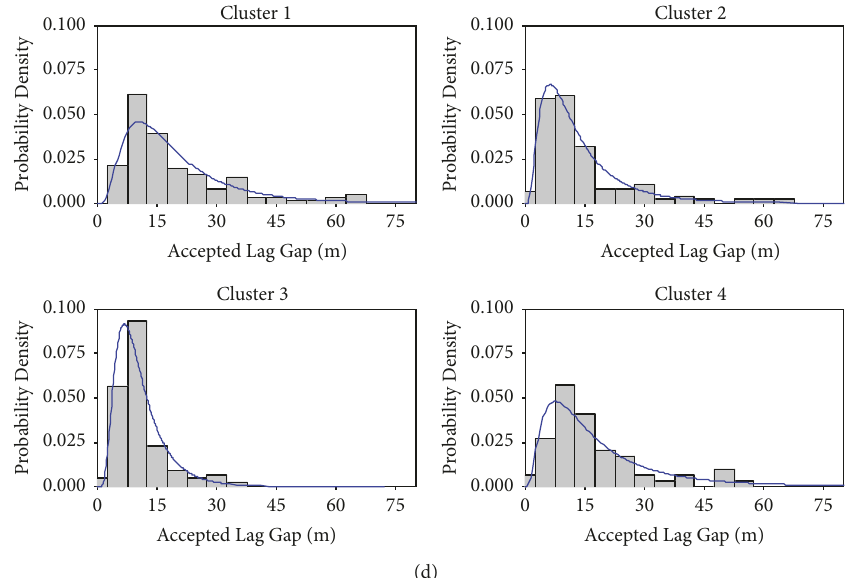
Figure 6: Best fitted distributions for (a) merging duration, (b) accepted gaps, (c) accepted lead gaps, and (d) accepted lag gaps for different clusters. Table 7: Results of the best fitted distributions for merging durations and gap acceptance parameters.